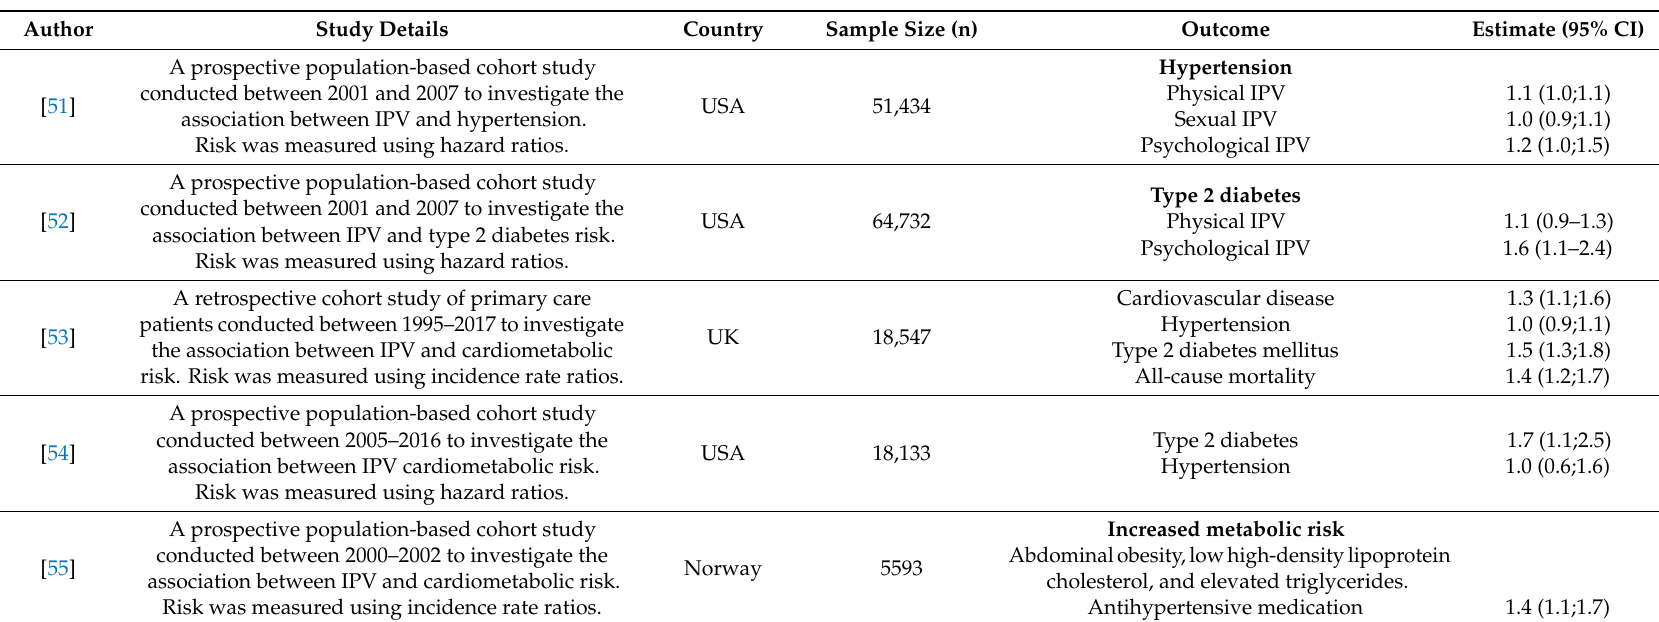
Table 1. Association between IPV and cardiometabolic